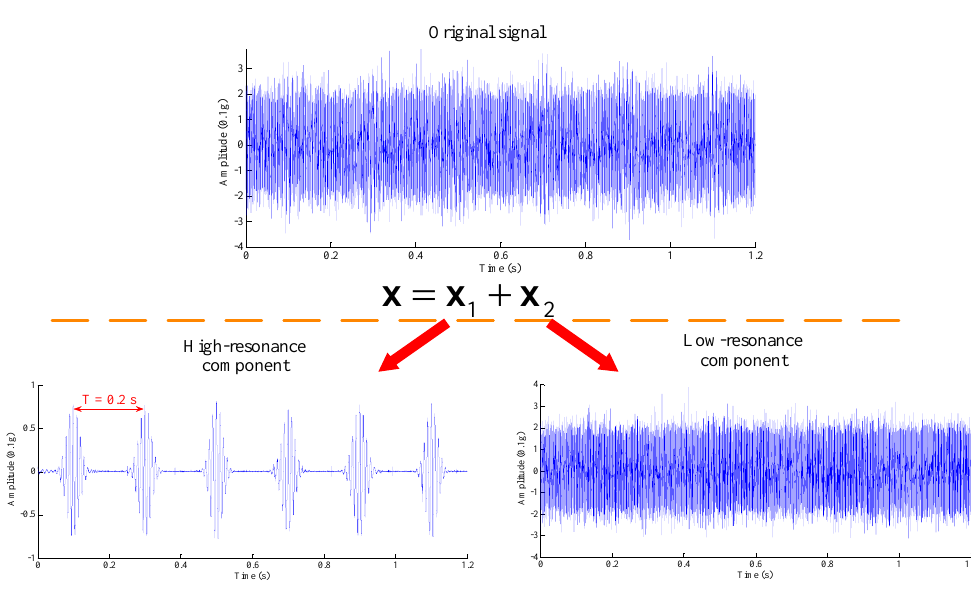
Figure 8. Illustration of resonance-based sparse signal decomposition (RSSD) performance.